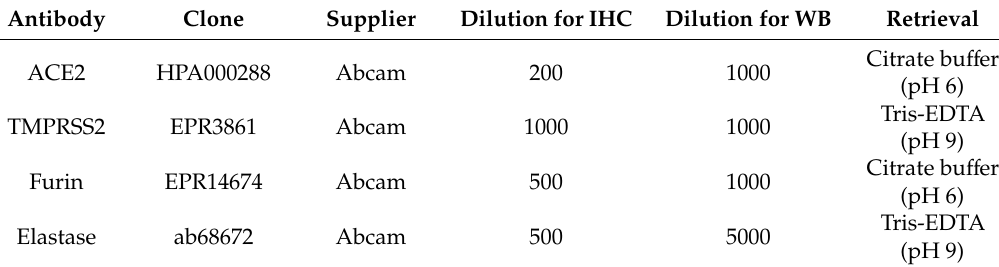
Table 2. Antibodies used for immunostaining and Western